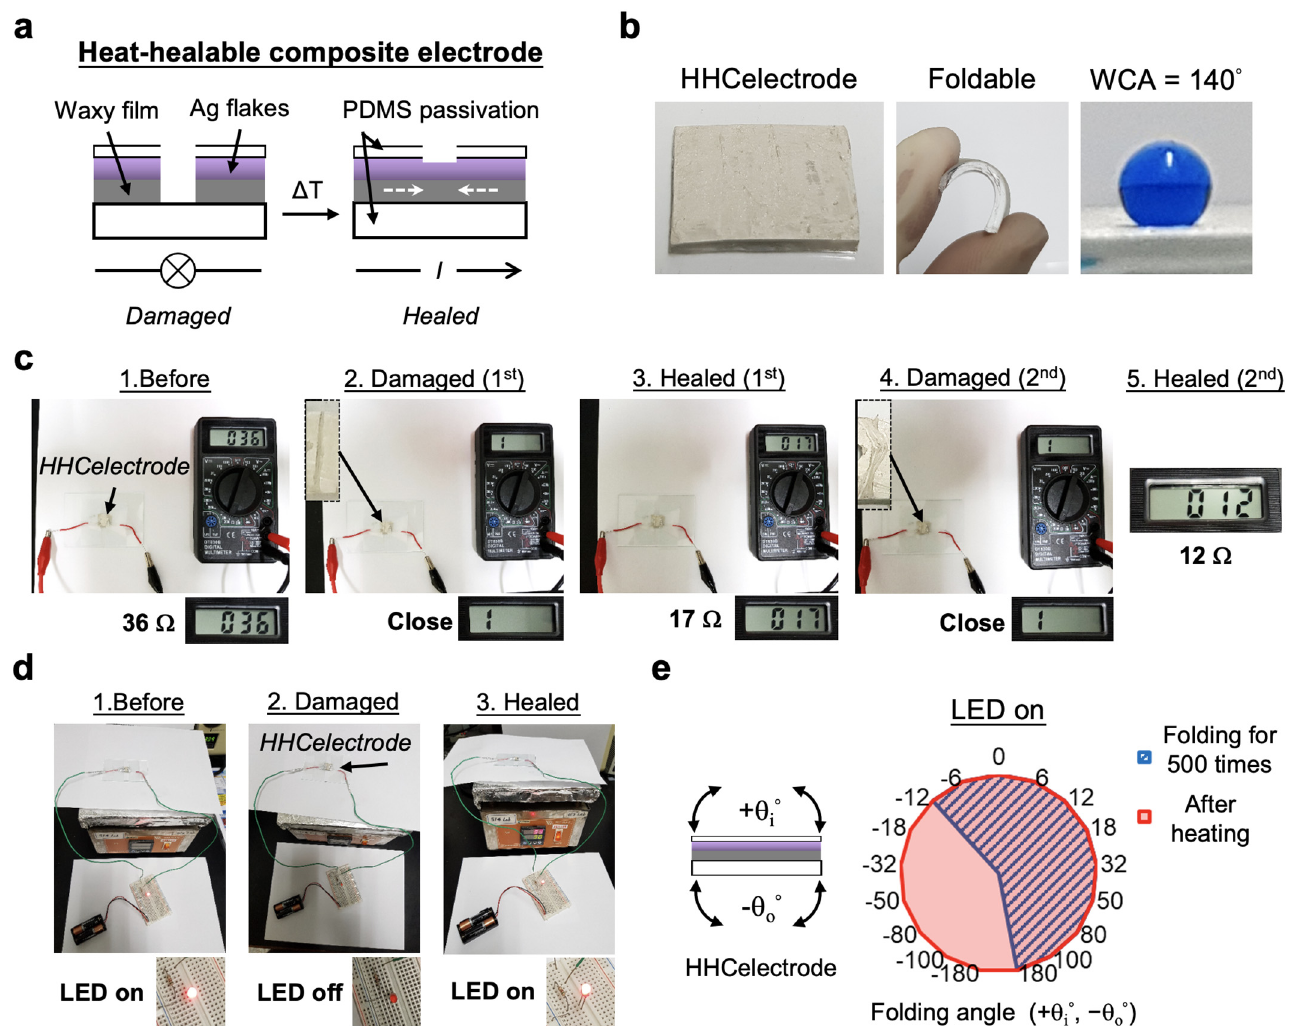
Figure 6. Heat-healable metal–elastomer composite electrode (HHCelectrode). ( a ) Concept and design of the HHCelec- trode. “ I ” denotes the open circuit when the damaged electrode was rescued. ( b ) Characteristics of the HHCelectrode. ( c ) Photographs showing the sequenced cracking and healing processes completed with the HHCelectrode, by measuring the resistance of the electrode. The size of the electrode was 1.24 × 1.24 cm 2 . The cracking activity was accomplished by cutting with tweezers. The size of the line crack was approximately 0.8~1.2 mm. The healing was completed at 60 °C for 1 min. ( d ) Demonstration of the rehealable ability of the electrode by lighting a LED. The electrode, with an area of 1.3 × 1.3 cm 2 , was in series both with a 510 Ω resistor and an LED triggered by two 1.5 V batteries. Damaging and healing were completed by cutting with tweezers and heating at 60 °C for 1 min, respectively. Panel 3 shows the continuous observation of the healed electrode after 1.5 h. ( e ) Characteristics of the foldable HHCelectrode by lighting a LED. Each measurement of individual folding angles was performed for 500 folds. The electrode had an area of 2.3 × 1.2 cm 2 . All measurements of the healed electrodes were performed at room temperature.